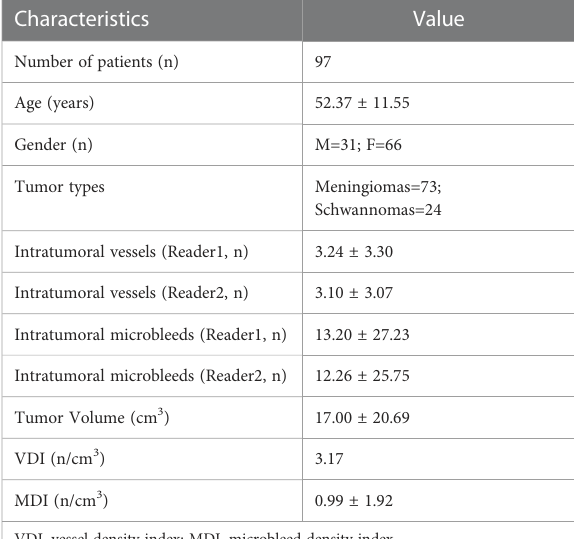
(5.48%) were atypical meningiomas, 3 (4.11%) were mixed meningiomas, 2 (2.74%) were hemangiomatous meningiomas, 2 (2.74%) were secretory meningiomas, 1 (1.37%) was chordoid meningioma, and 1 (1.37%) was calcifying psammomatous meningioma. Comparison between fi brous meningiomas and epithelial meningiomas based on CE-T 1 WI FSBB images revealed differences in the number of intratumoral microbleeds ( P <0.01), MDI values ( P <0.01), and sex of patients ( P <0.05) (Table 3). The odds ratios (OR) of microbleeds and male sex for diagnosing epithelial meningiomas rather than fi brous meningiomas were 9.53 and 4.43, respectively. There were no differences in the number of intratumoral vessels ( P =0.97), VDI values ( P =0.91), or tumor volume ( P =0.71). The ages of the two groups of patients were not statistically different ( P =0.94).